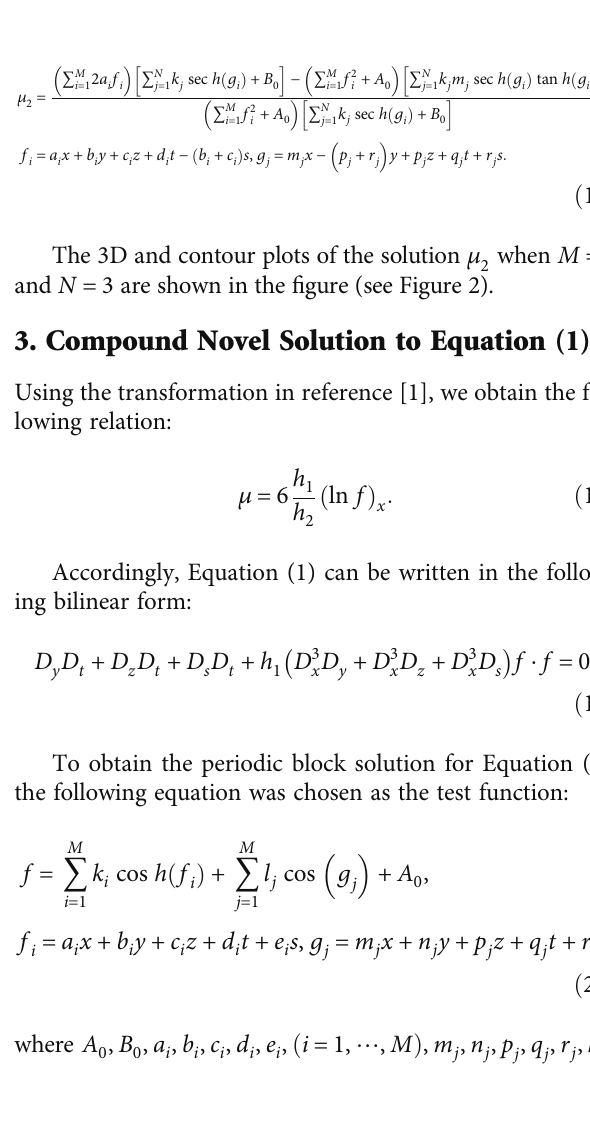
= B = a = c = b = c = d = q = r = r = m = m = q = 1, b 0 1 1 2 2 2 1 2 2 3 1 3